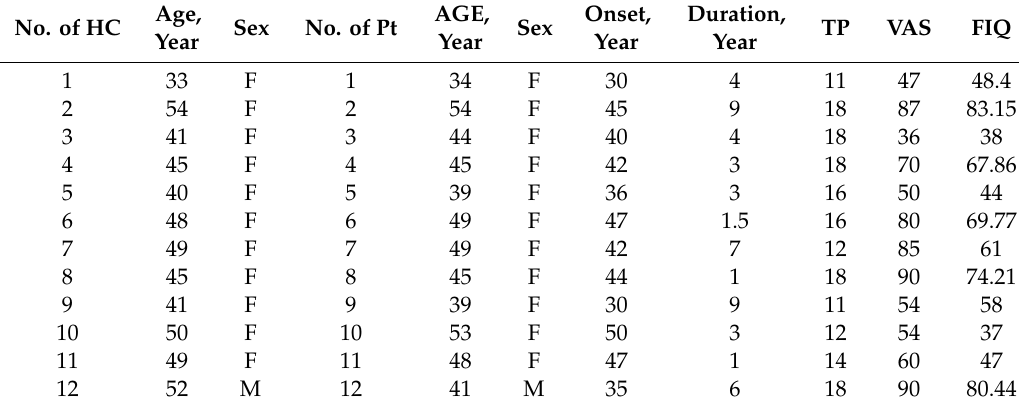
Table 1. Demographic and clinical data of twelve patients (Pt) su ff ering from fibromyalgia and twelve healthy controls (HC).